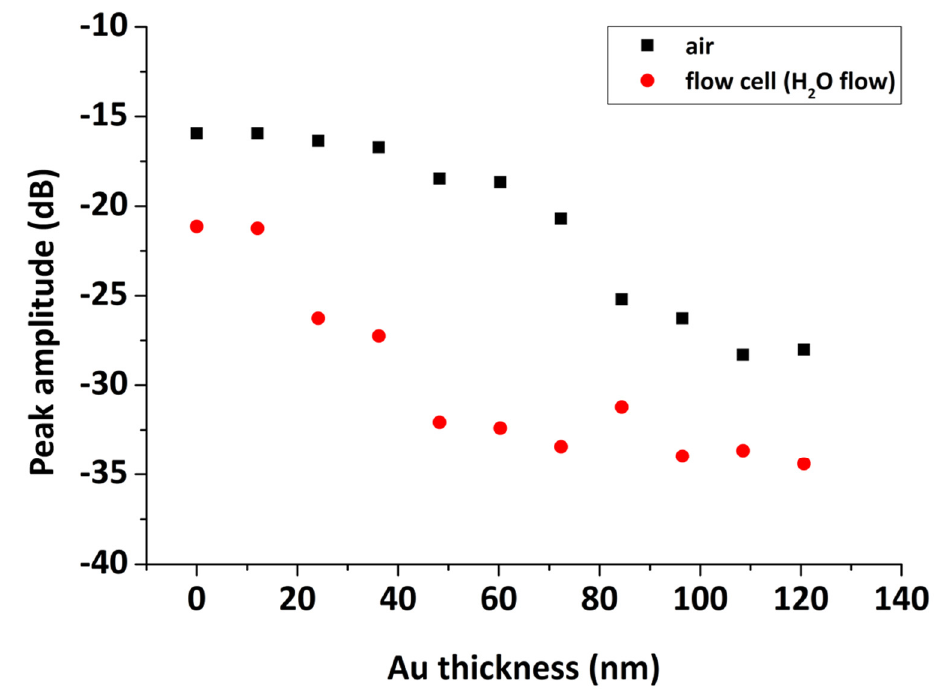
Figure 8. Peak amplitude versus Au layer thickness up to 120 nm, deposited on the PMMA-coated sensor surface, in air and in H 2 O flow.